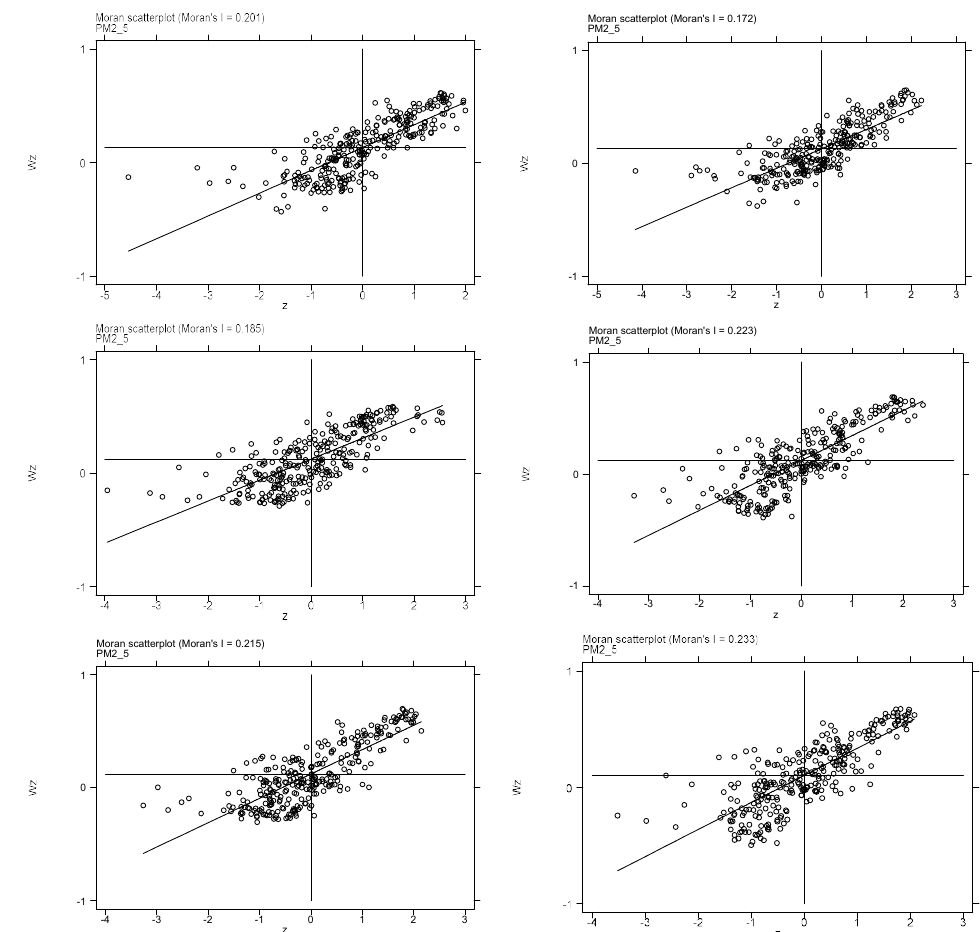
Figure 2. Scatter plots of the local Moran’s index of air pollution in Chinese cities.